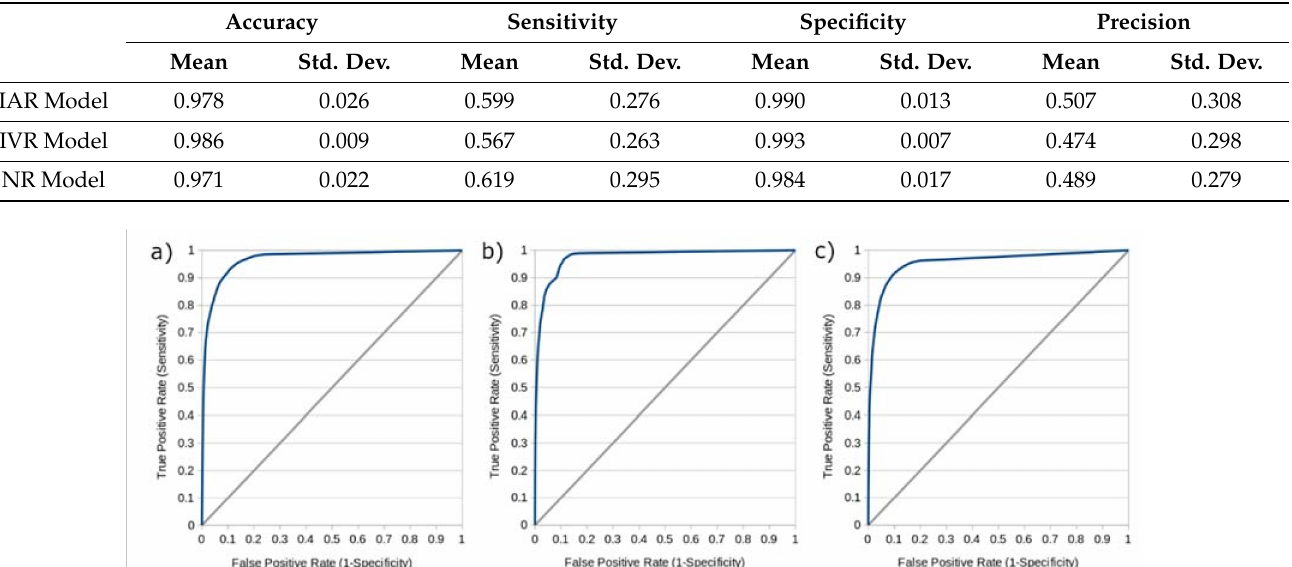
Figure 4. Receiver operating characteristic (ROC) curves for the standard predictions of each model. Recanalization outcomes for the models are ( a ) IAR (intra-arterial therapy, recanalizing), ( b ) IVR (intravenous tPA, recanalizing), and ( c ) NR (non-recanalizing). AUC values are ( a ) 0.979, ( b ) 0.976, and ( c )